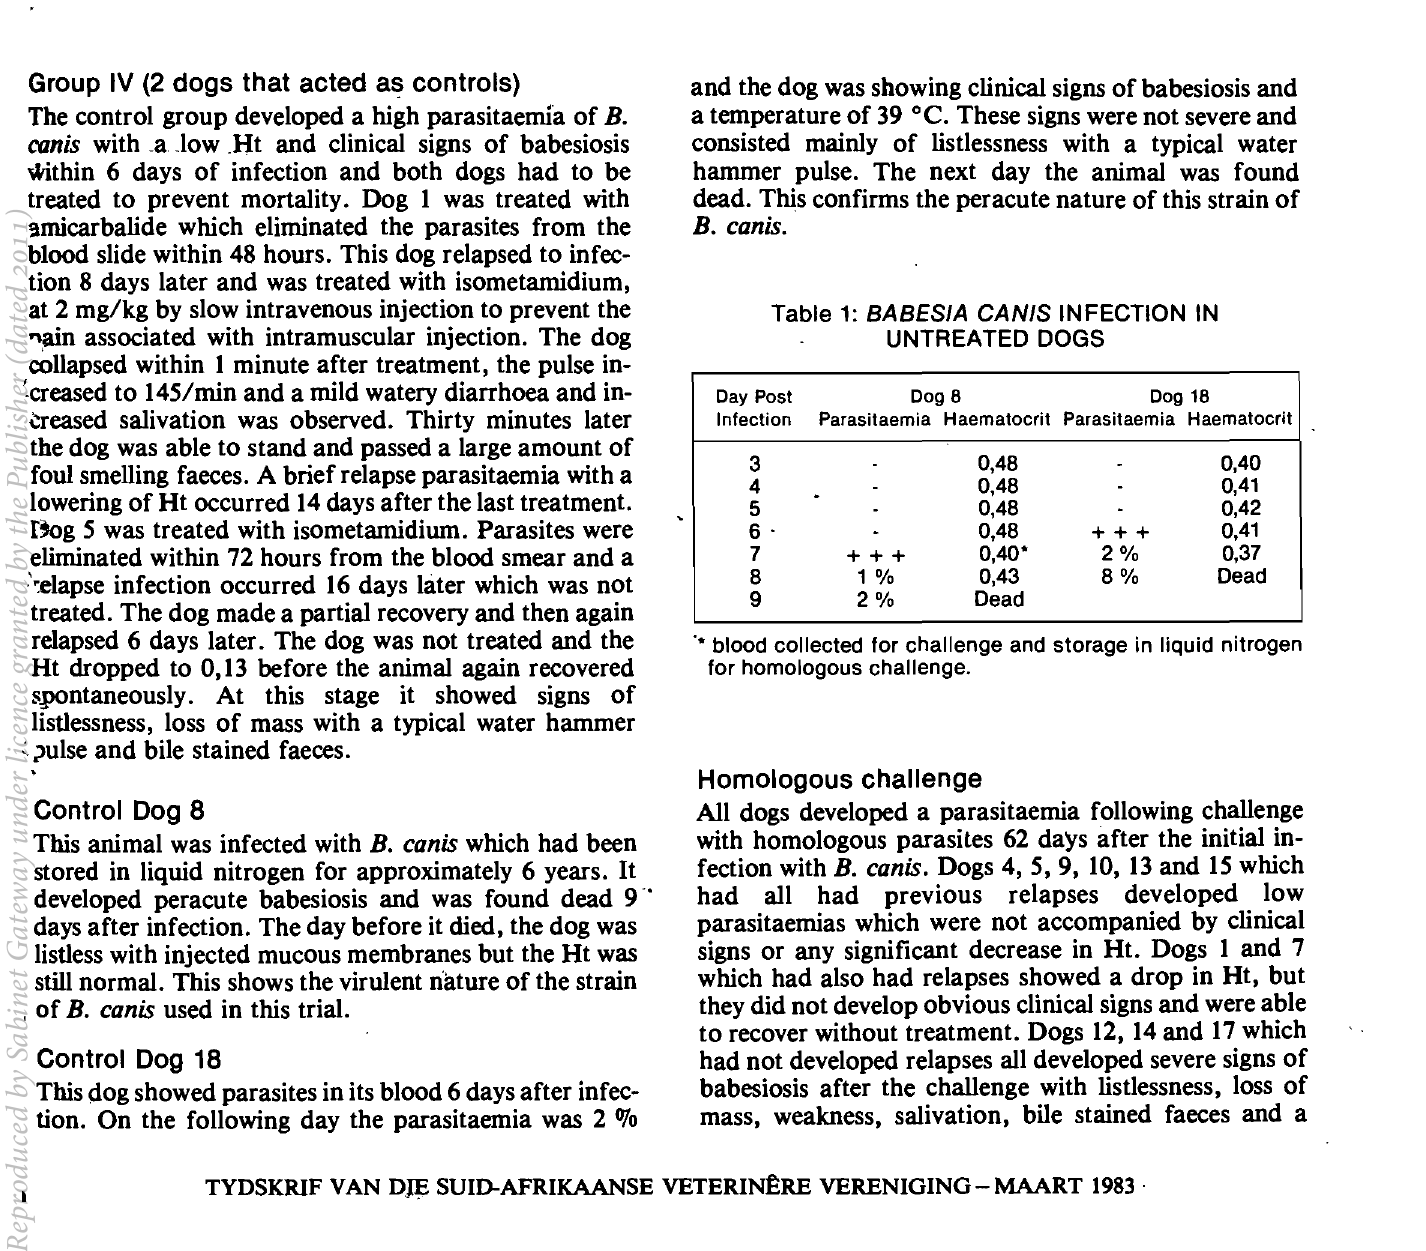
Fig. 4: Control group. Primary infection of B. canis treated to prevent mortality and the effect on subsequent immunity .• Parasitaemia - Ht